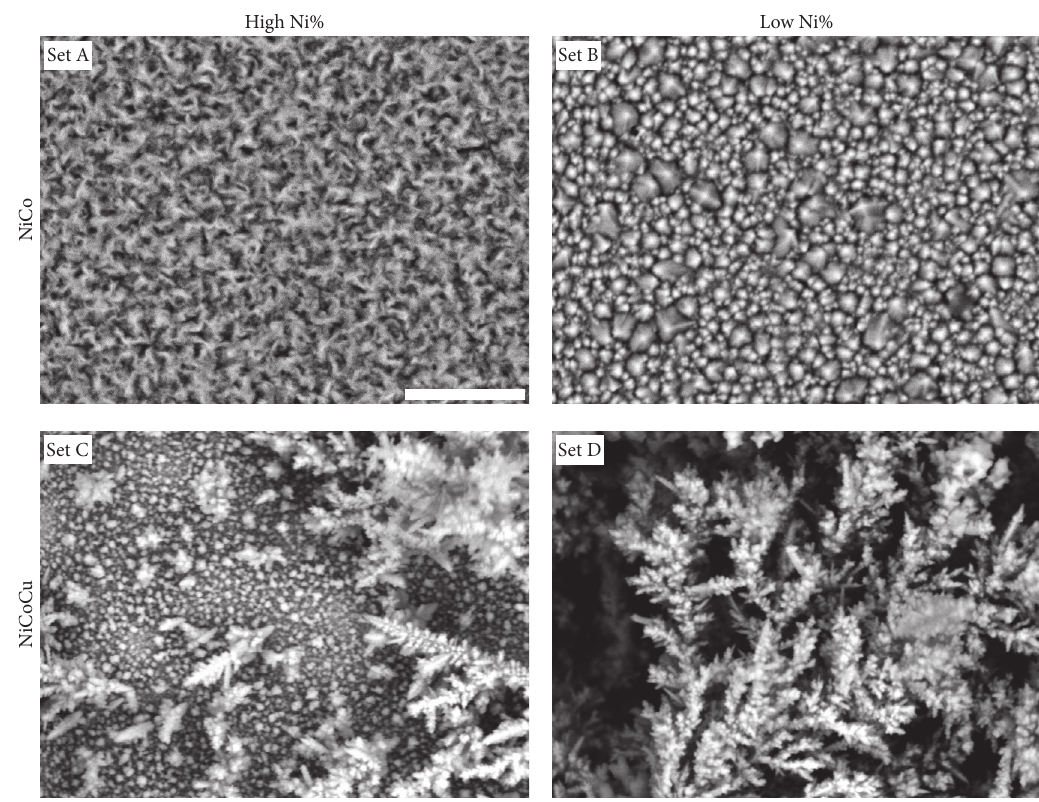
Figure 3: Example SEM images of samples from all four sets before the dealloying procedure. The scale bar is 5 𝜇 m for all the images.